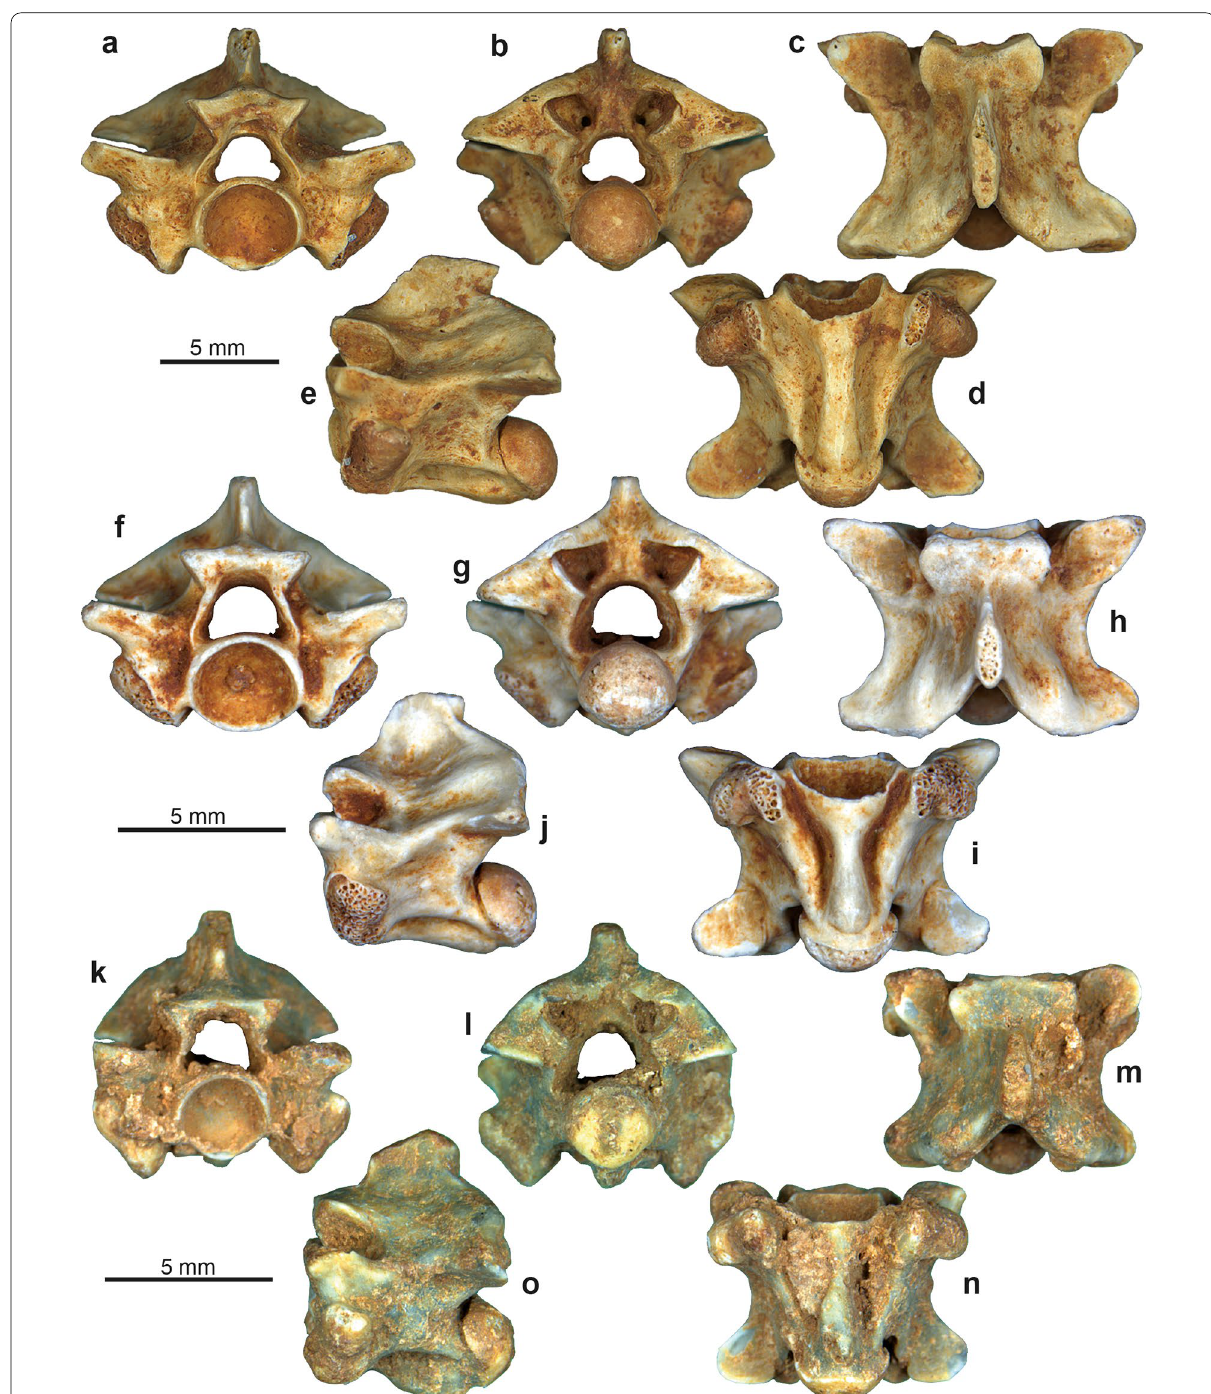
Fig. 93 Phosphoroboa filholii comb. nov. from imprecisely known locality(ies) in the Phosphorites du Quercy: a – e posterior trunk vertebra (YPM-VPPU 30393) in anterior ( a ), posterior ( b ), dorsal ( c ), ventral ( d ), and left lateral ( e ) views; f – j posterior trunk vertebra (YPM-VPPU 30394) in anterior ( f ), posterior ( g ), dorsal ( h ), ventral ( i ), and left lateral ( j ) views; k – o posterior-most trunk vertebra (YPM-VPPU 30395) in anterior ( k ), posterior ( l ), dorsal ( m ), ventral ( n ), and left lateral ( o )